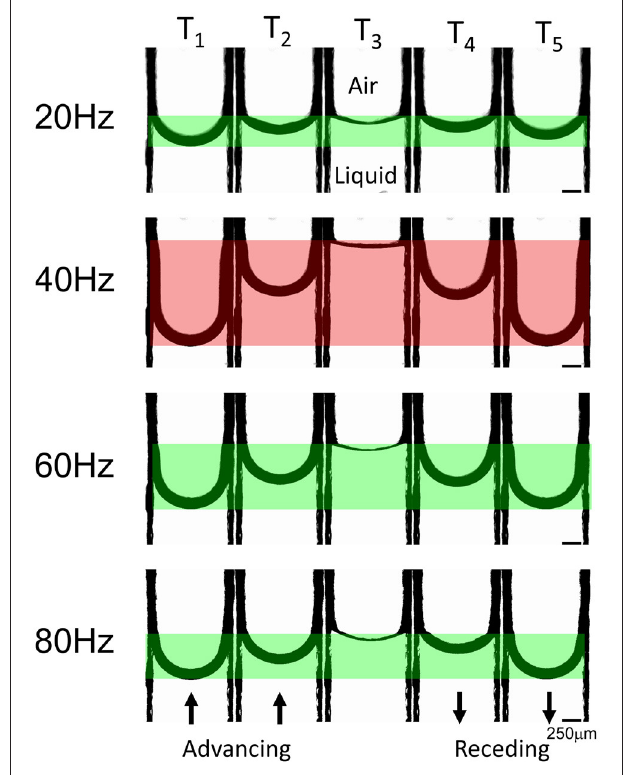
FIGURE 5 | Interface profiles at 5 time instants ( T 1 − T 5) during an oscillation cycle for four different frequencies, illustrating that the maximum amplitude of the displacement is a non-monotonic function of frequency. T1 represents the minimum position and T3 the maximum position of the cycle. Data are for PEO5 oscillating in the range [20–80] Hz, driven by a 1 p max = 700 Pa